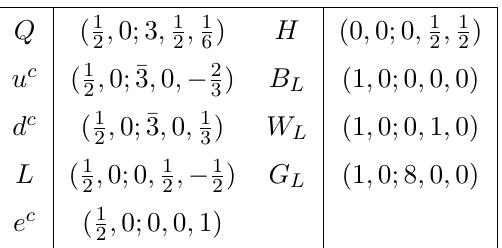
Table 1 . Representations used in the Hilbert series construction. Hermitian conjugate represen- tations have SU(2) L $ SU(2) R and all gauge representations replaced by their conjugates (when